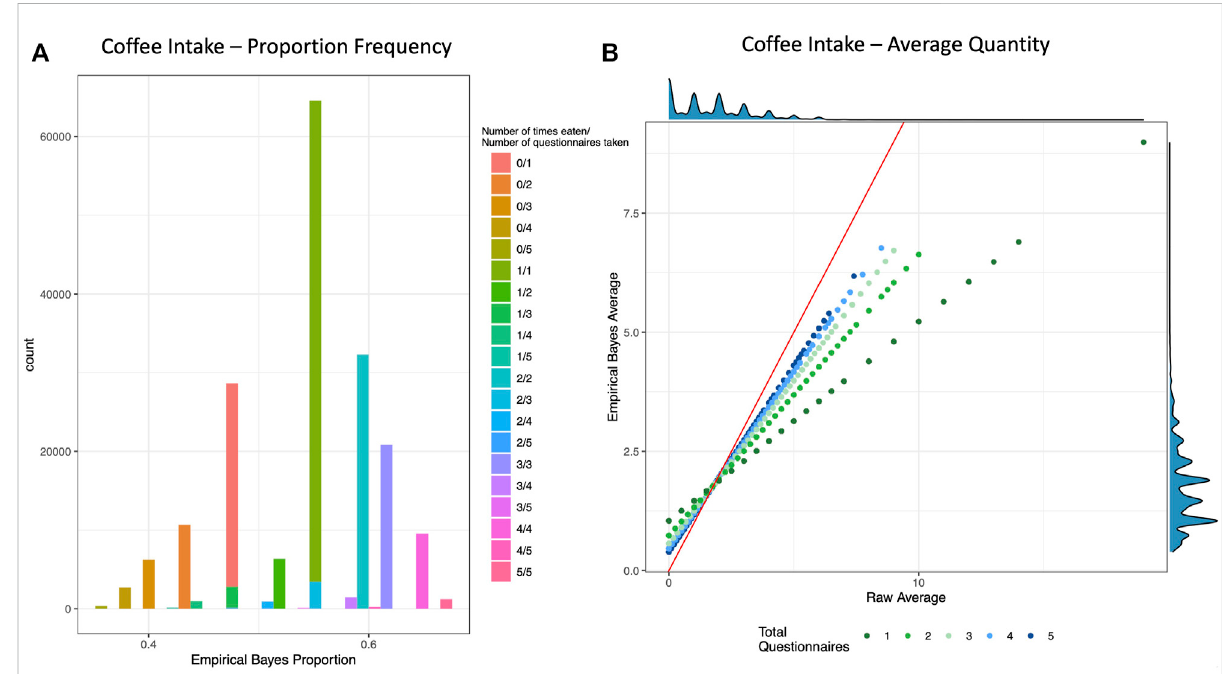
FIGURE 1 Empirical Bayes Proportion and Average Transformations: Coffee Intake. These example visualizations of coffee intake depict the shrinking of raw values for individuals with fewer total questionnaires. (A) Histogram of Empirical Bayes proportion colored and stacked by the crude proportion (number of times an individual reported drinking coffee out of how many total questionnaires that individual took). (B) Scatter plot of the crude average ( x -axis) vs.the Empirical Bayes Average ( y -axis)of cupsof coffee per day, colored by totalnumberof questionnairestaken. The redline is the line of identity, and the density plots are depicted on the top and right borders. See Supplementary Figure S3 for more